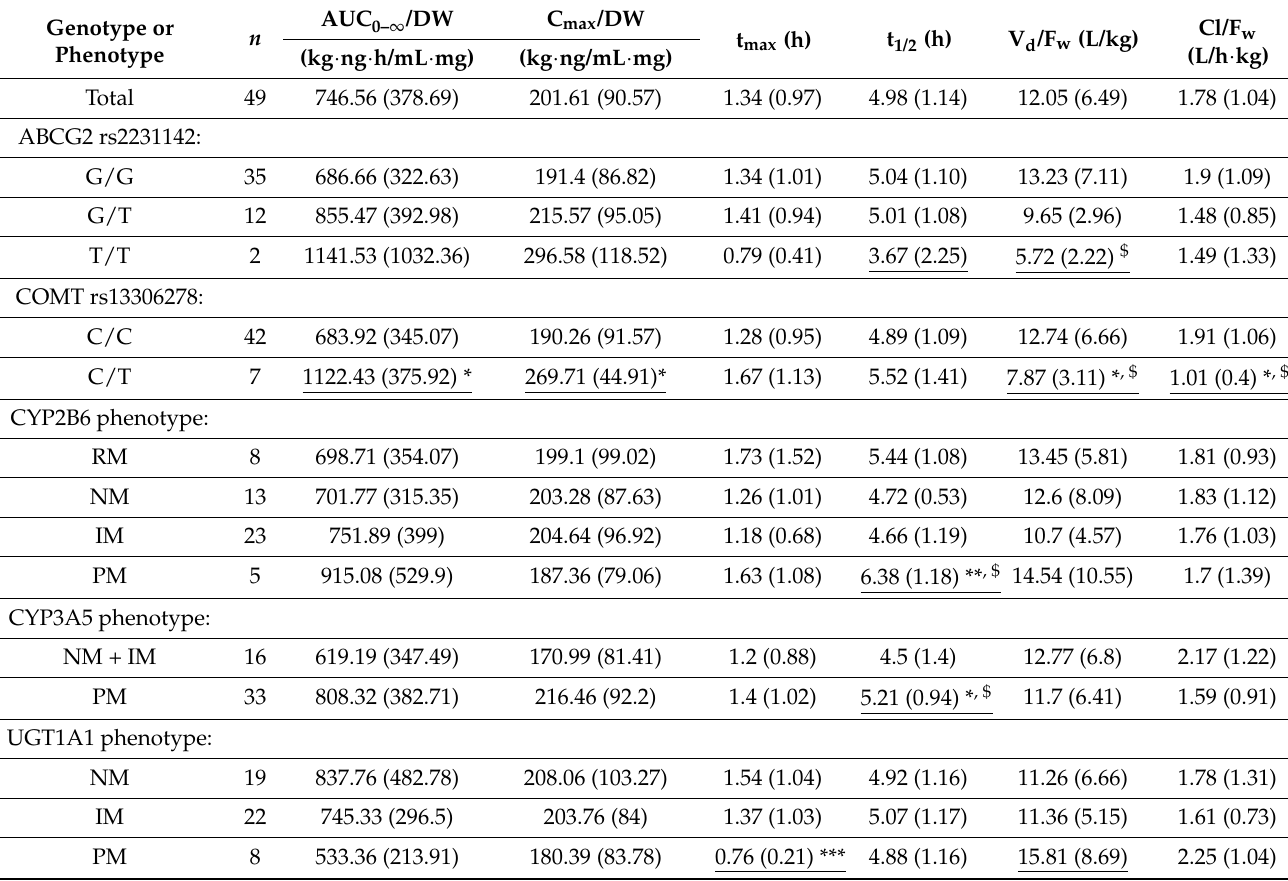
Table 4. Pharmacokinetic parameters according to genotypes and phenotypes showing statistically significant differences. Genotype